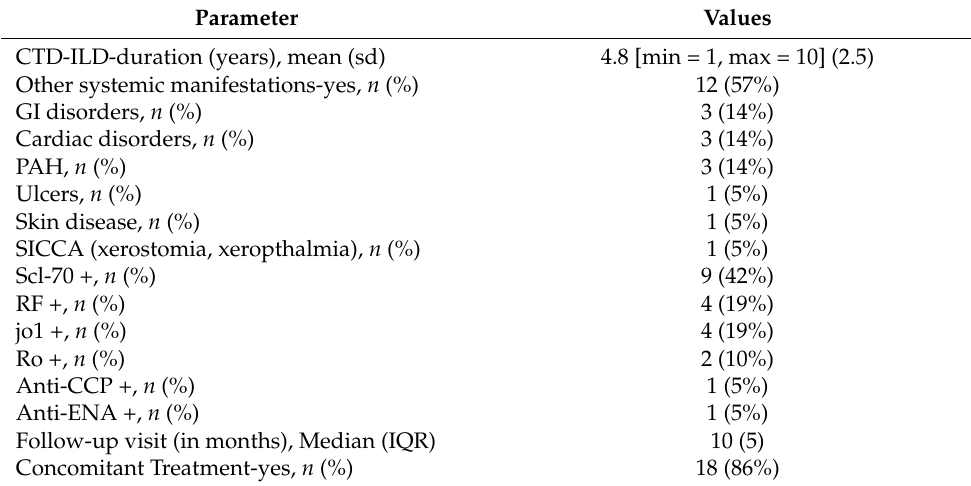
Table 1. Cont. Parameter Values CTD-ILD-duration (years), mean (sd)